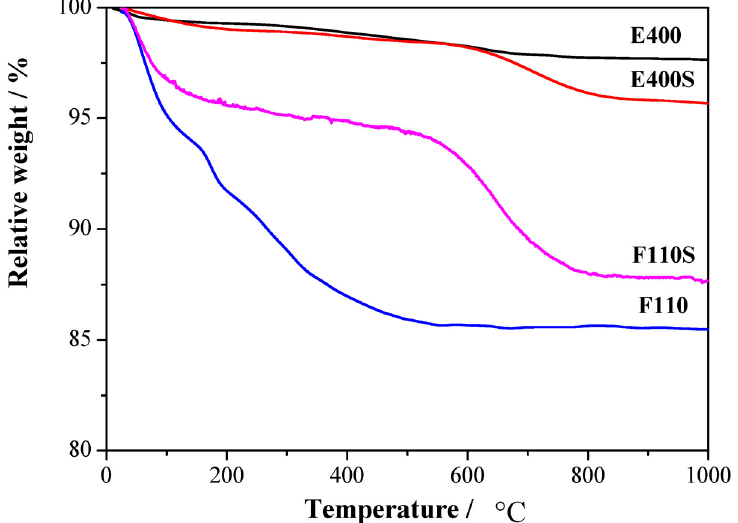
Figure 2. Thermal gravimetric (TG) analysis responses for the four synthesized